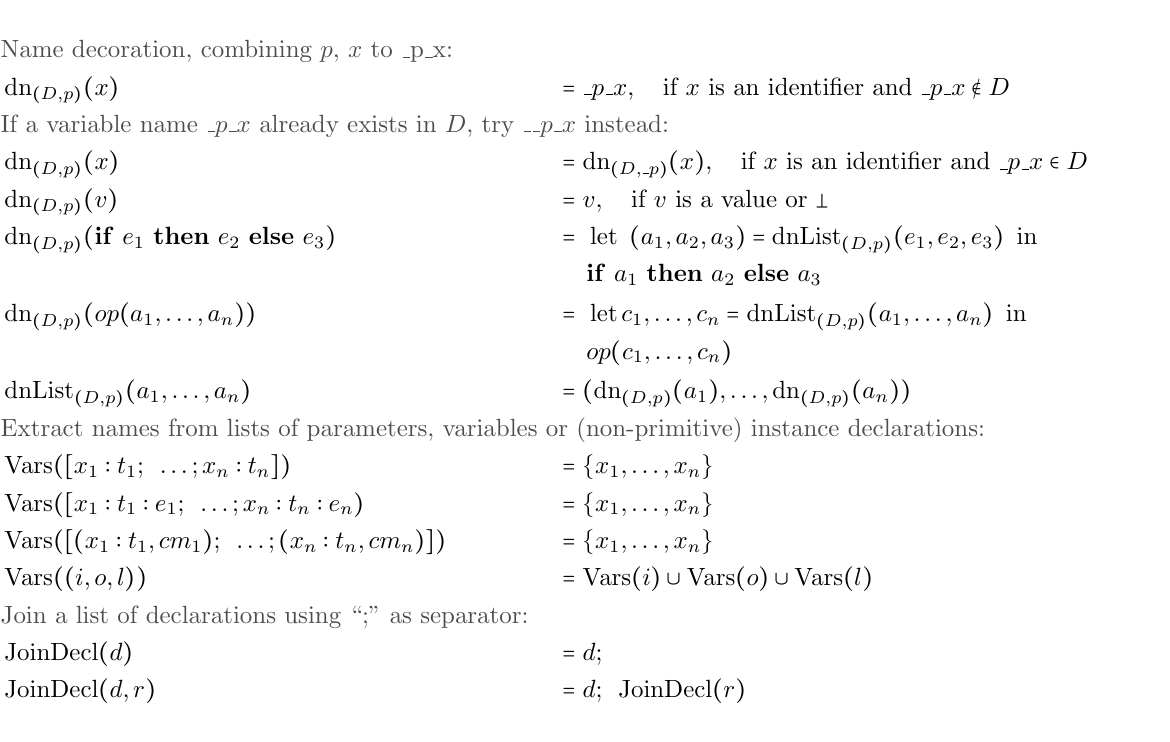
Figure 16: Auxiliary functions for the